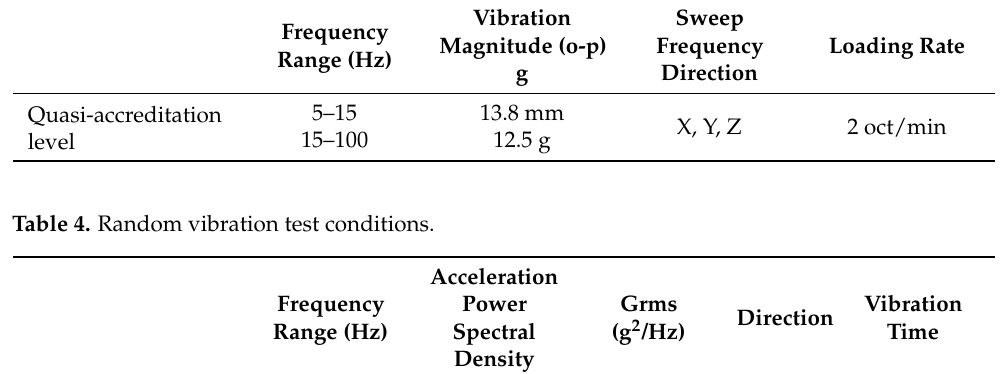
Table 3. Sinusoidal vibration test conditions.